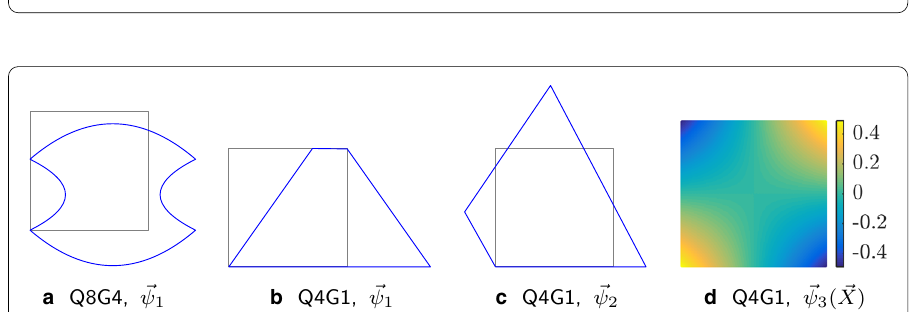
Fig. 3 L 2 errors of a single element internal forces ( a ) and stiffnesses ( b ) as a function of the number of Gauss integration points. The accuracy is measured relative to the force or stiffness matrix obtained for the maximum number of integration points used ( n g = 13 for triangles and n g = 49 for quadrilaterals). Solid lines correspond to f e 0 or K e 00 , dashed lines to f e 1 or K e 11 , and dash-dot lines to K e 01 = ( K e 10 ) T sub-matrices of f e M or K e M in Eqs. (18) and (21); elements from Table 1 are used. Configuration of the element corresponds to homogeneous overall deformation (cid:2)∇(cid:2) v 0 = − 0 . 05 (cid:2) e 2 (cid:2) e 2 with an affine micromorphic field v 1 ( (cid:2) X ) = ( X 1 + X 2 + 3) / 2, X i ∈ [ − 0 . 5 , 0 . 5], i = 1 , 2 (microstructure with a square stacking of holes used, i.e., n =